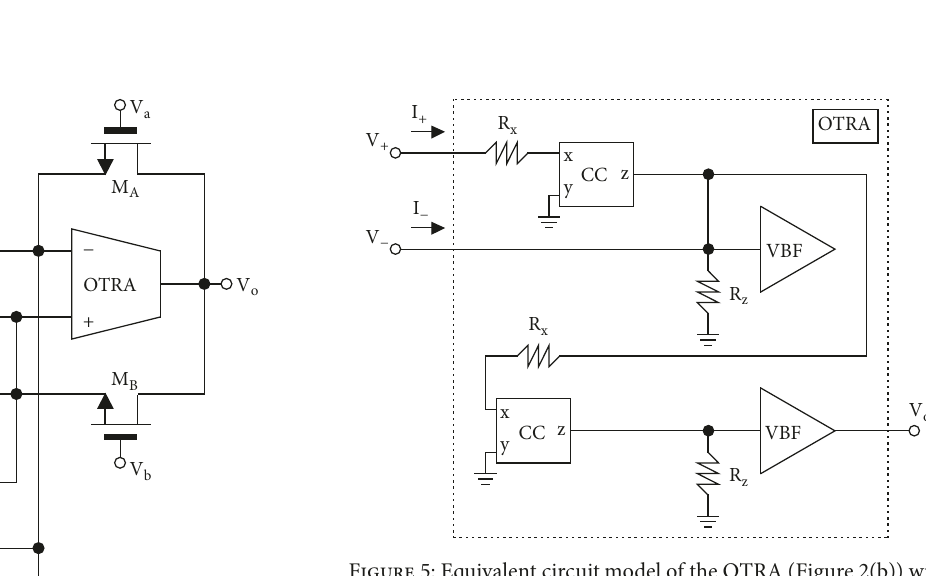
Figure 3: The proposed full-phase operation transresistance-mode precision full-wave rectifier: (a) circuit diagram and (b) input and output transfer characteristics.